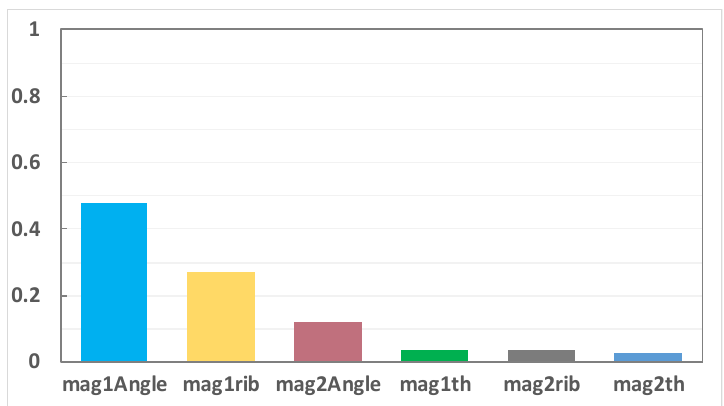
Figure 10. Average torque-optimal factor contribution.